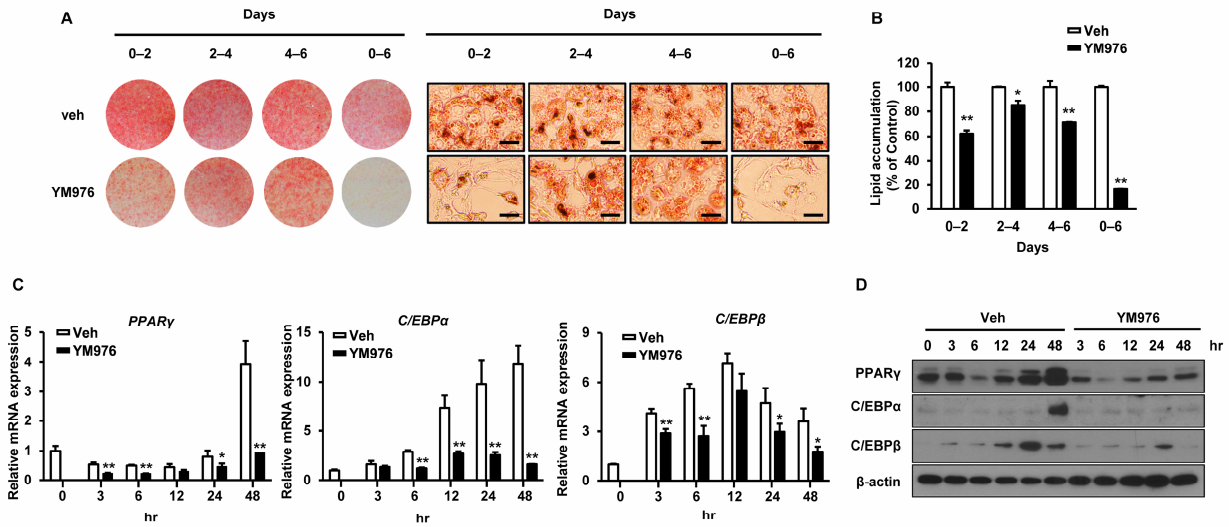
Figure 2. The inhibitory effect of YM976 occurs in the early stage of adipocyte differentiation. 3T3-L1 cells were induced for differentiation and then treated with Veh or 10 µM of YM976 at the indicated time points. ( A ) Cells were stained with Oil Red O and analyzed by microscopy. Scale bar = 100 µ m. ( B ) Quantification of Oil Red O staining by spectrophotometry. ( C ) The mRNA expression of PPARγ, C/EBPα, and C/EBPβ was analyzed by qRT-PCR. ( D ) Protein levels of PPARγ, C/EBPα, and C/EBPβ were analyzed by Western blot. In ( B , C ), n = 3 per group. Images and blots are representative of three independent experiments. Values indicate mean ± SD. * p < 0.05; ** p < 0.01. Data were assessed using Student’s t -test.